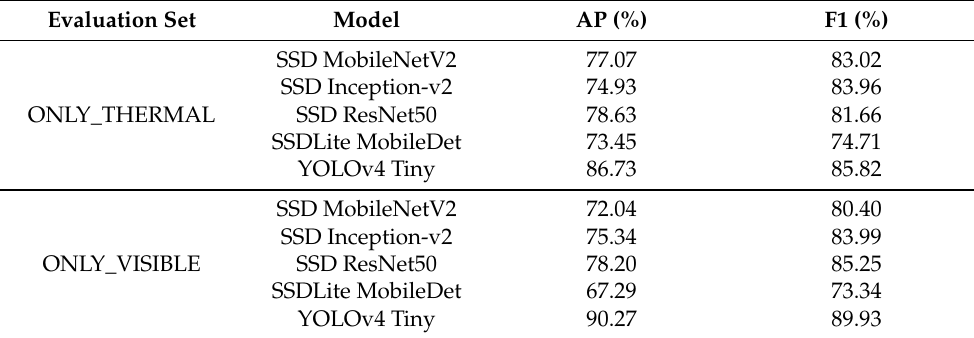
Table 7. Evaluation results for experiment #2 in terms of AP and F1 score considering all detections (confidence threshold of